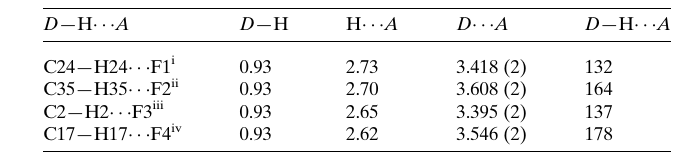
Table 1 Hydrogen-bond geometry (A˚ , (cid:3) ).